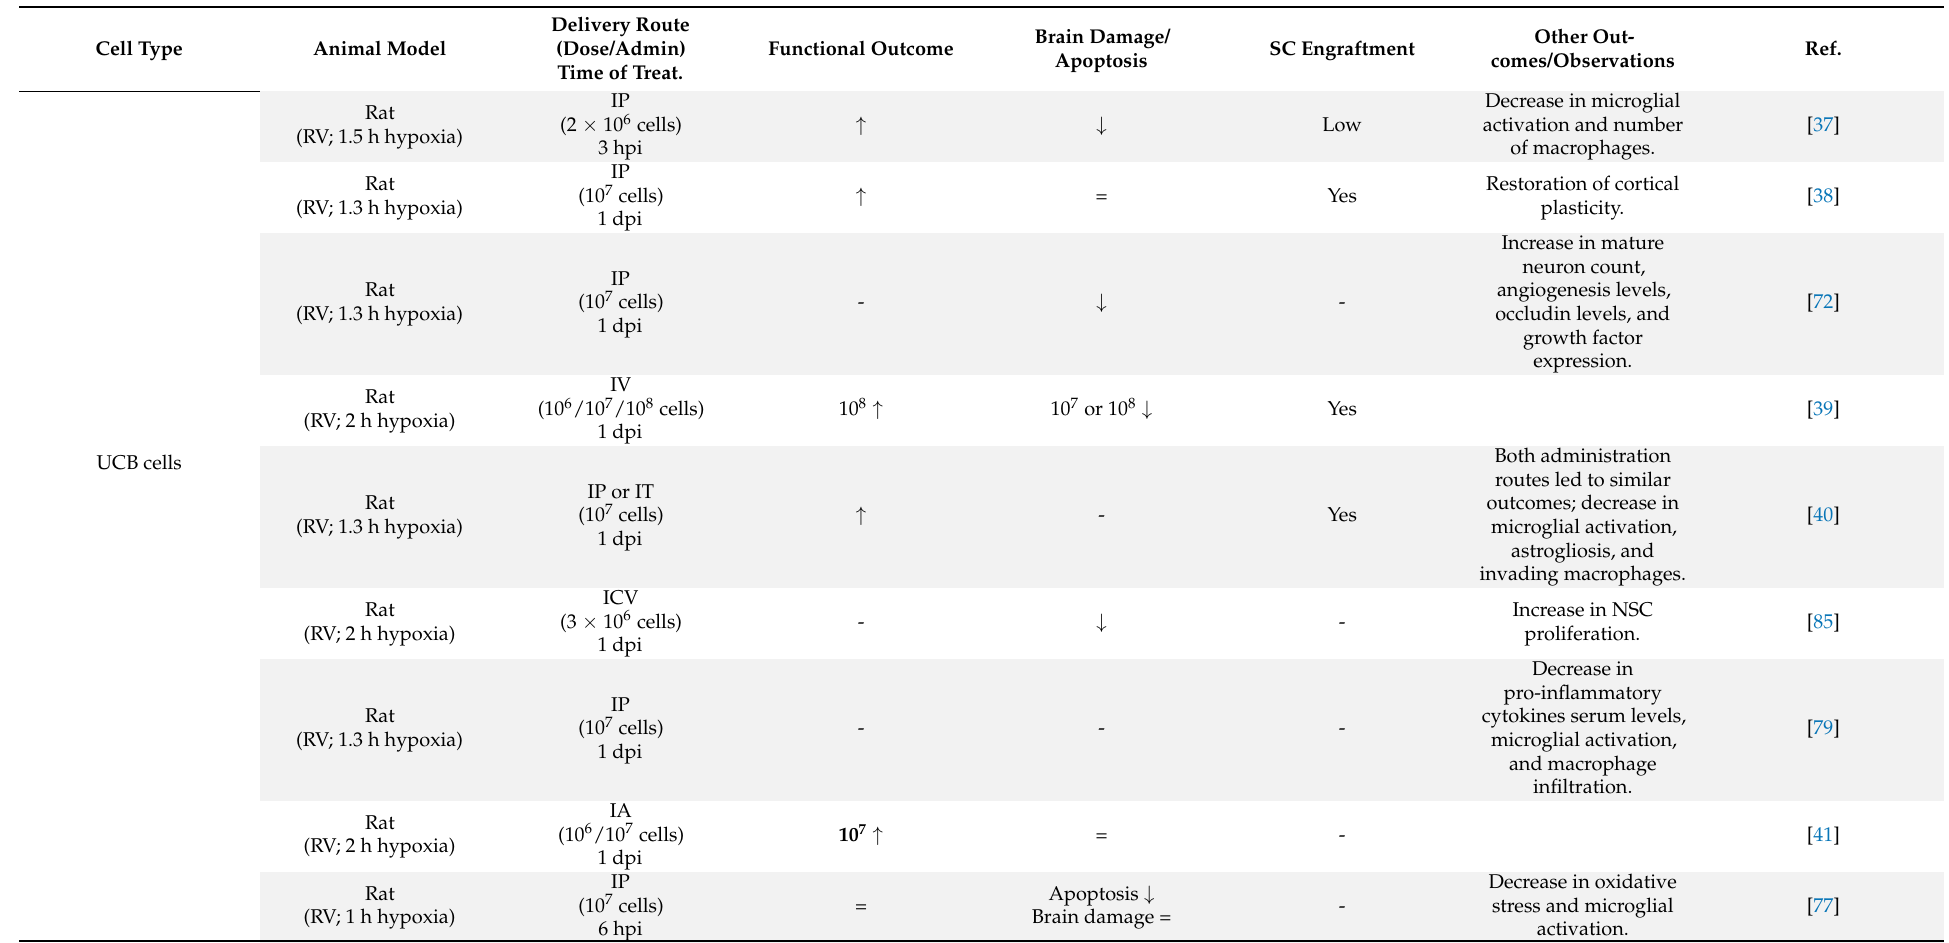
Table 1. Studies focusing on the therapeutic potential of umbilical cord blood cells and umbilical cord blood and umbilical cord tissue stem/stromal cells from human origin (except when mentioned otherwise) in animal models for hypoxic-ischemic